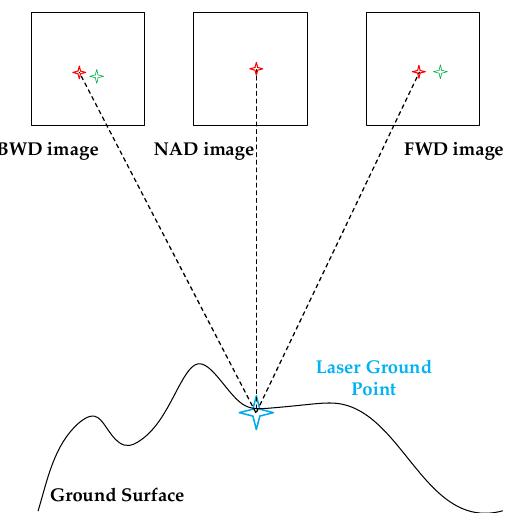
Figure 4. Principle of constraints in image space for the combined adjustment model.